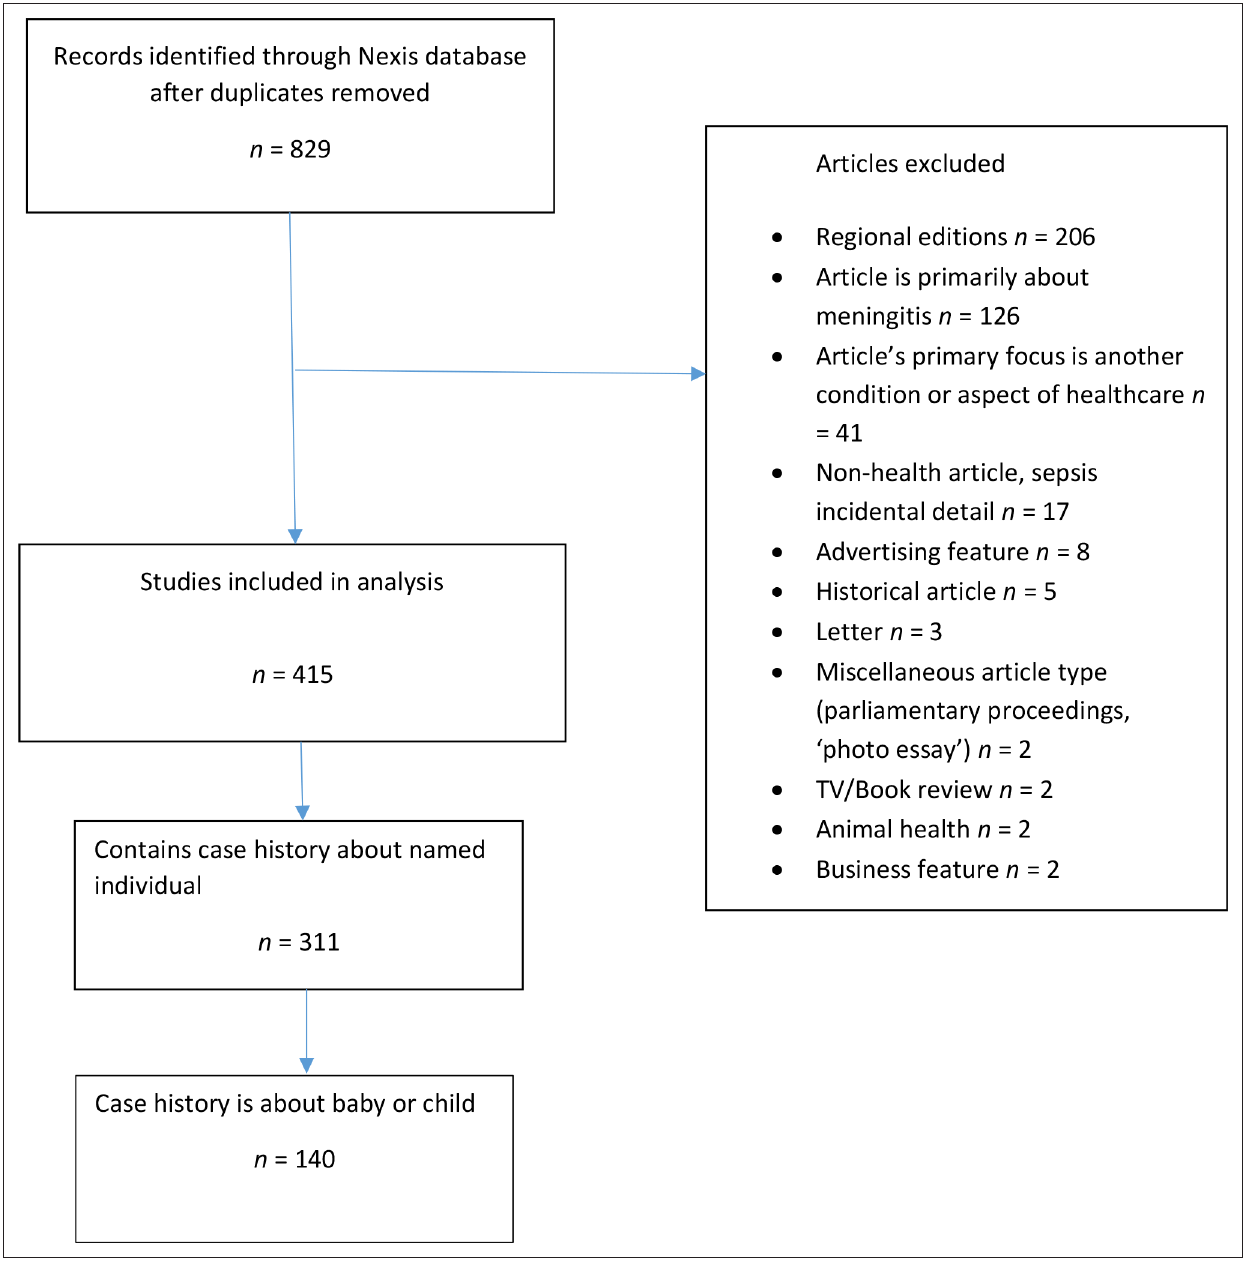
Figure 1 PRISMA diagram of study